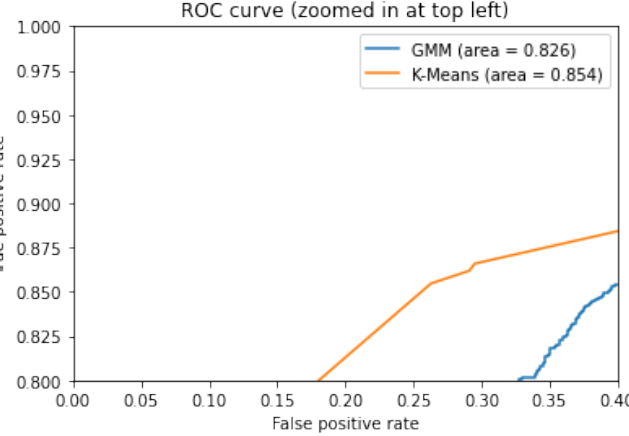
Figure 24. ROC curve for GMM and K-Means, showing the rate of false alarms versus true alarms.